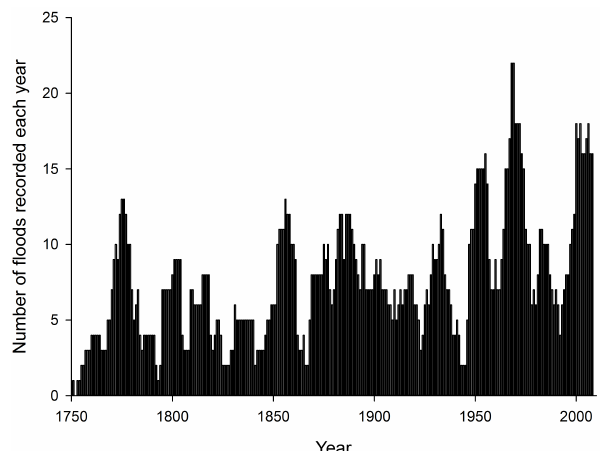
Figure 4. Number of floods with a recorded/estimated discharge exceeding the 0.9